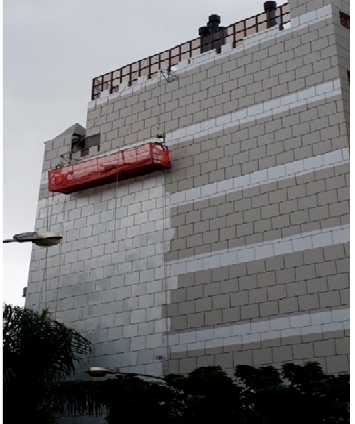
Figure 8. On the right, the finishing coat after application.